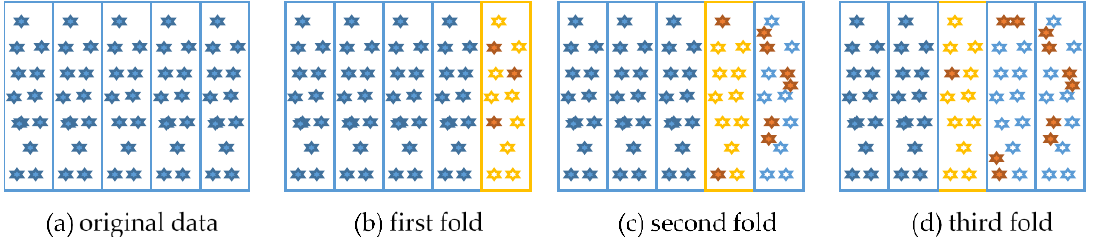
Figure 3. The schematic diagram of boosting K-Fold LGB. The training sets of each fold are determined by the previous fold’s predicted results.